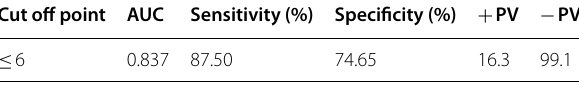
PV Negative predictive value, −